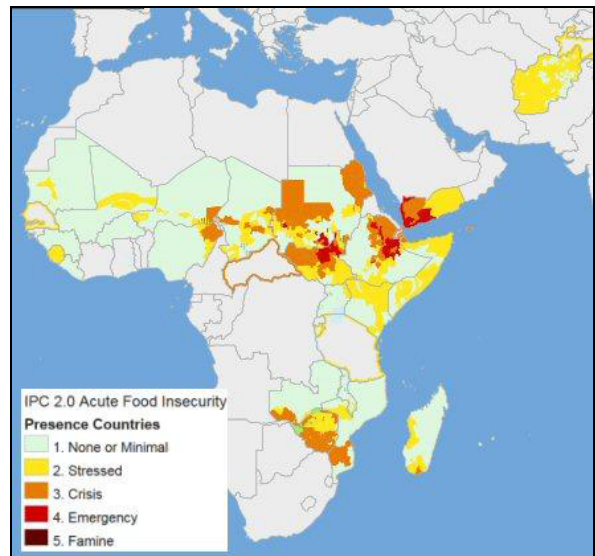
Figure 3: Acute Food Insecurity predicted in March 2016 for period June – September 2016 in Africa and Middle East (FEWS Net